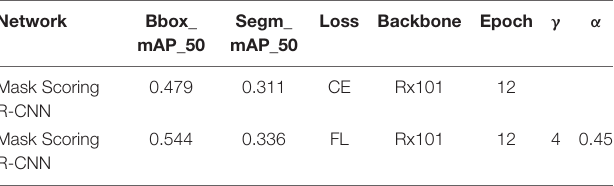
TABLE 7 | Training parameter and test results based on Mask Scoring R-CNN with different loss functions.